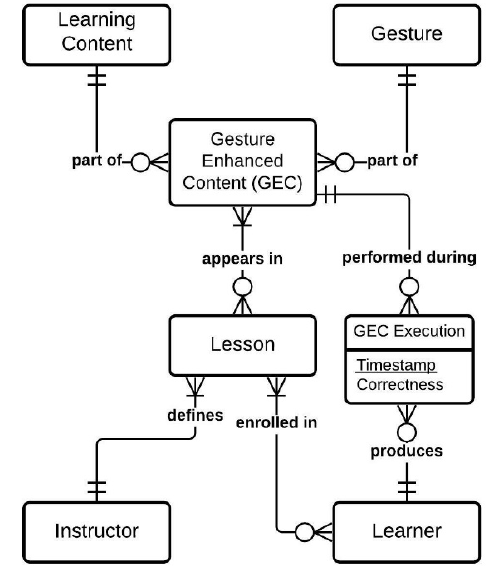
Figure 1. The entity-relationship diagram of the e-GAL data model in crow’s foot notation.